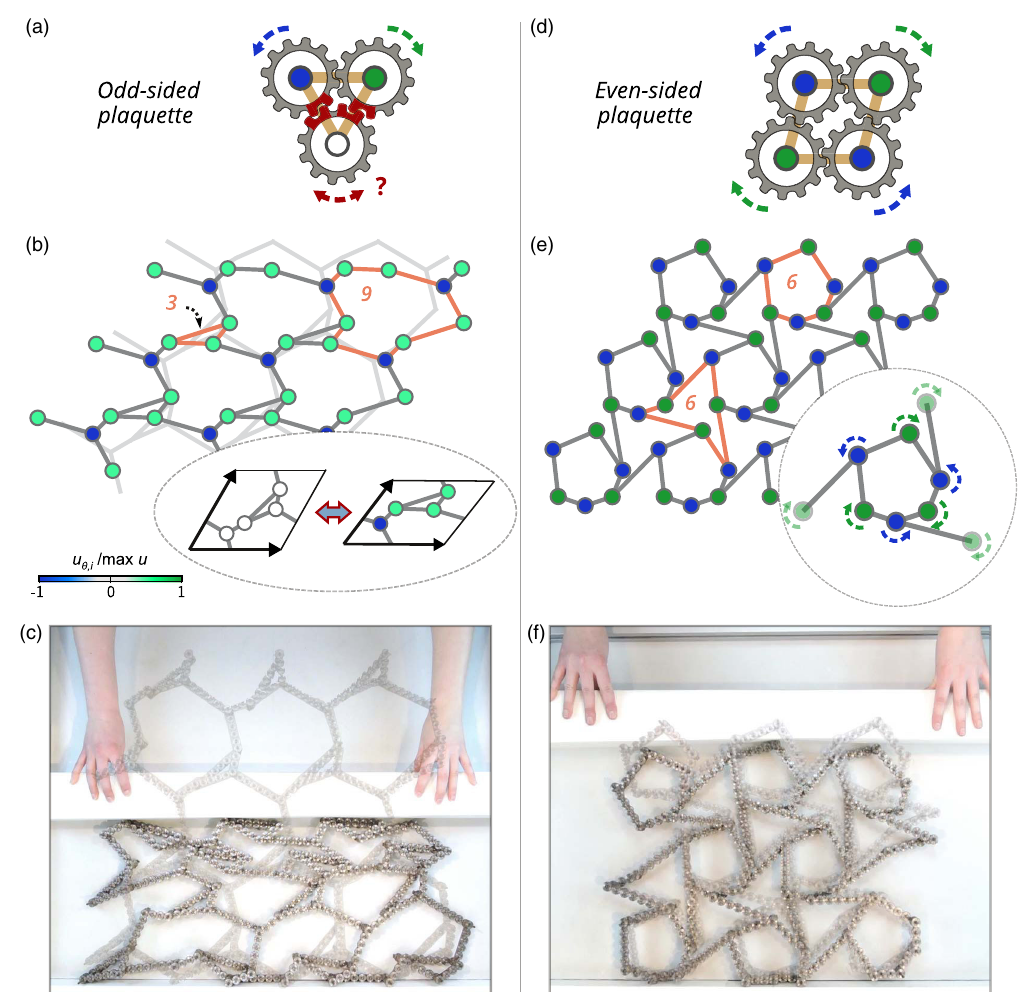
FIG. 4. Frustration and global deformations in martini and hexachiral lattices. Maxwell gear lattices with gapped spectra have a global zero-energy mode that differs qualitatively in the martini and hexachiral designs. (a) When an odd number of links is connected in a loop, rotation of gears without node displacements is frustrated. (b) The martini lattices have only odd-sided plaquettes with either 3 or 9 links (highlighted). Therefore, the zero-energy mode (visualized in the overlay) is a Guest-Hutchinson mode that requires point displacements as well as a distortion of the unit cell. The zoom shows the zero-energy deformation of the unit cell, including the change in primitive lattice vectors. (c) A prototype martini lattice with free boundaries cannot resist vertical compression (horizontal bar being pushed down) because of the Guest-Hutchinson mode (the precompression configuration is shown in overlay). (d) Gears on an even- sided loop of links can counterrotate freely without node displacements. (e) A hexachiral lattice consists solely of six-sided plaquettes (highlighted). It can be divided into two sublattices, with all gears rotating counterclockwise (blue) on one sublattice and clockwise (green) by the same amount on the other without frustration. This is the required global zero-energy mode of the periodic system, which does not displace any nodes. (f) The absence of a unit-cell-shape changing mode imparts stability to the hexachiral lattice, which largely maintains its shape under uniform